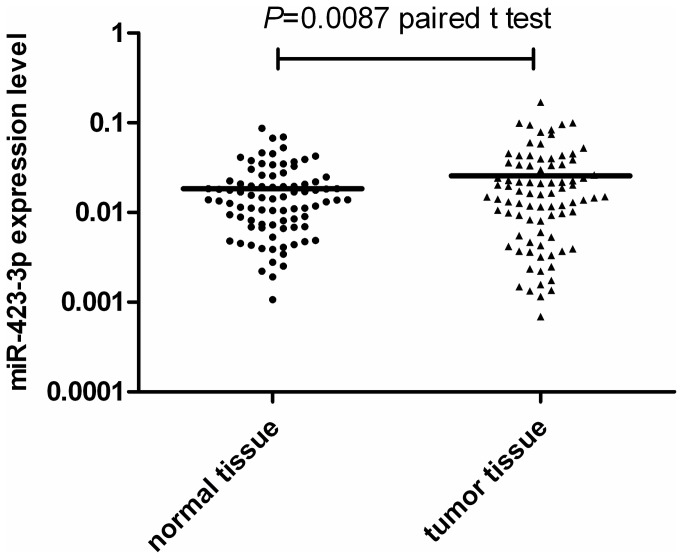
miR-423-3p expression is up regulated in tumour tissue.miR-423-3p levels were determined in normal and tumour tissue samples from OSCC patients (N=85) by RT-PCR as described in Materials and Methods (bars show group mean values). All values were normalized to 18s RNA levels. The Paired t-test was used to evaluate differences in expression levels between normal and tumour samples. Mean expression levels were: 1.843*10-2 in normal tissue samples and 2.562*10-2 in tumour tissue samples.